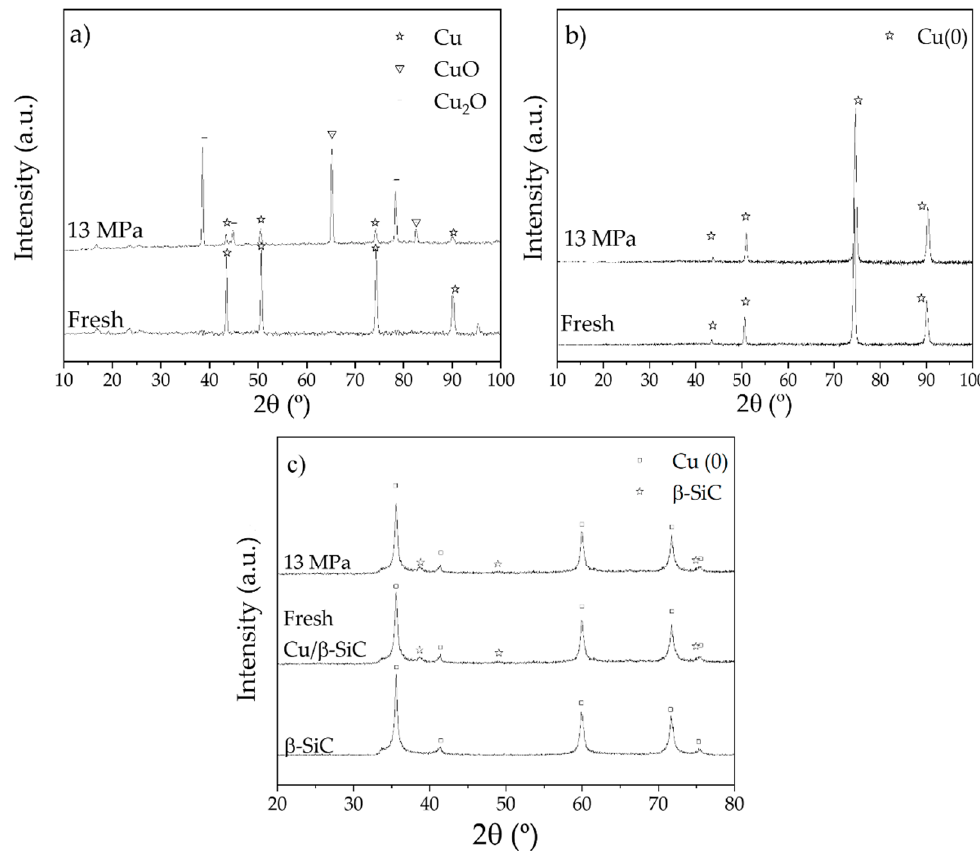
Figure 2. XRD spectra of fresh catalysts and after scCO 2 at 13 MPa and 35 °C ( a ) Cu Wire ( b ) the Cu Plate and ( c ) Cu/ β -SiC.